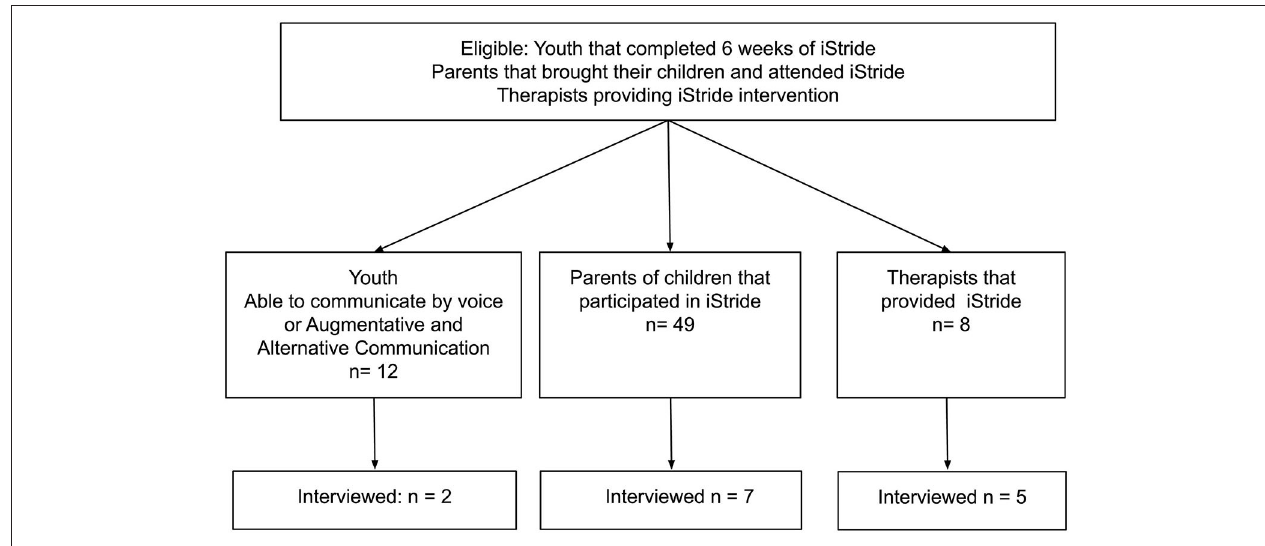
FIGURE 1 | Qualitative study flow chart.